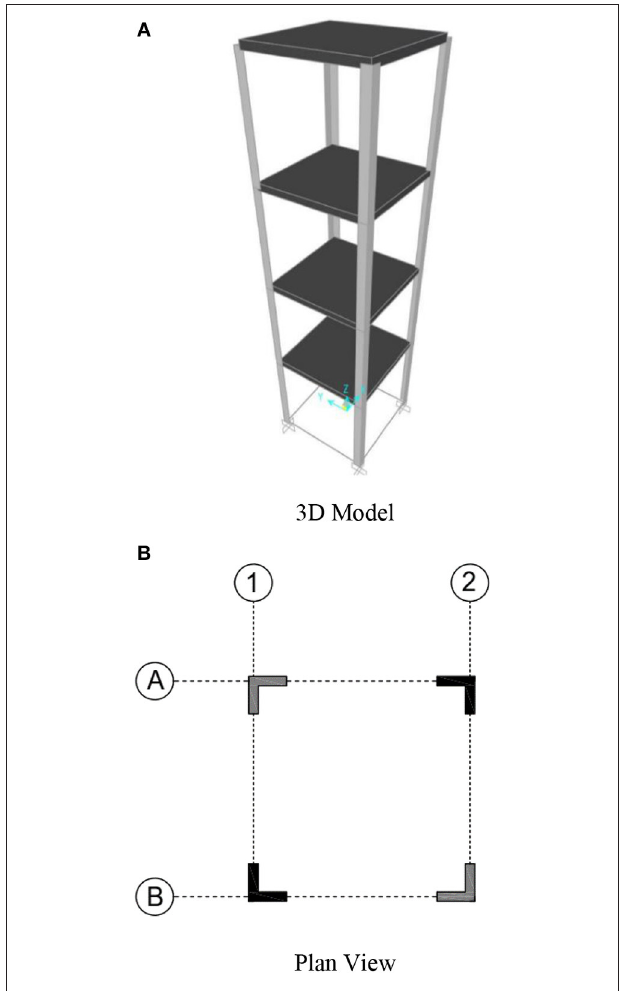
FIGURE 5 | FE Model for steel structure. (A) 3D model. (B) Plan